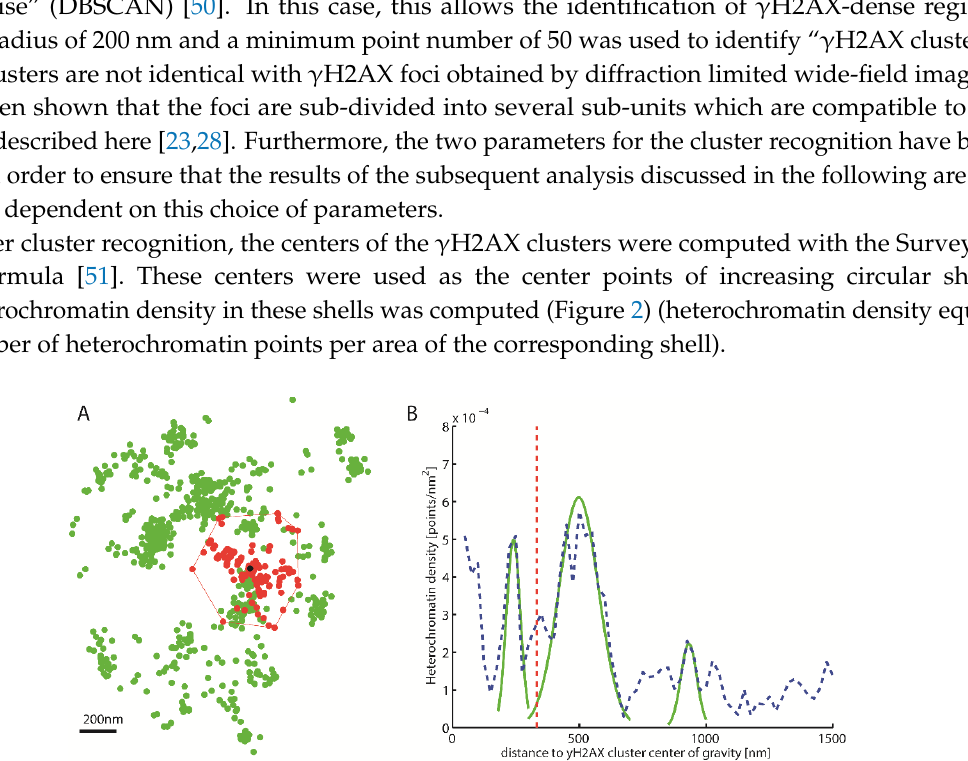
Figure 2. Density distribution around γH2AX cluster. ( A ) Schematic representation of a γH2AX cluster (red) recognized by Density-Based Spatial Clustering of Applications with Noise (DBSCAN), the center of gravity (black) and the heterochromatin (green) around it. ( B ) Density distribution of heterochromatin around the γH2AX cluster center of gravity (blue). This density distribution is used to classify whether a cluster is heterochromatin-associated. For this purpose, the local maxima are approximated by Gaussian functions (green). The amplitude of these maxima is then compared with the predetermined threshold value. The red line represents half the mean square distance of the convex hull of the cluster (i.e., a kind of “radius” of the cluster).